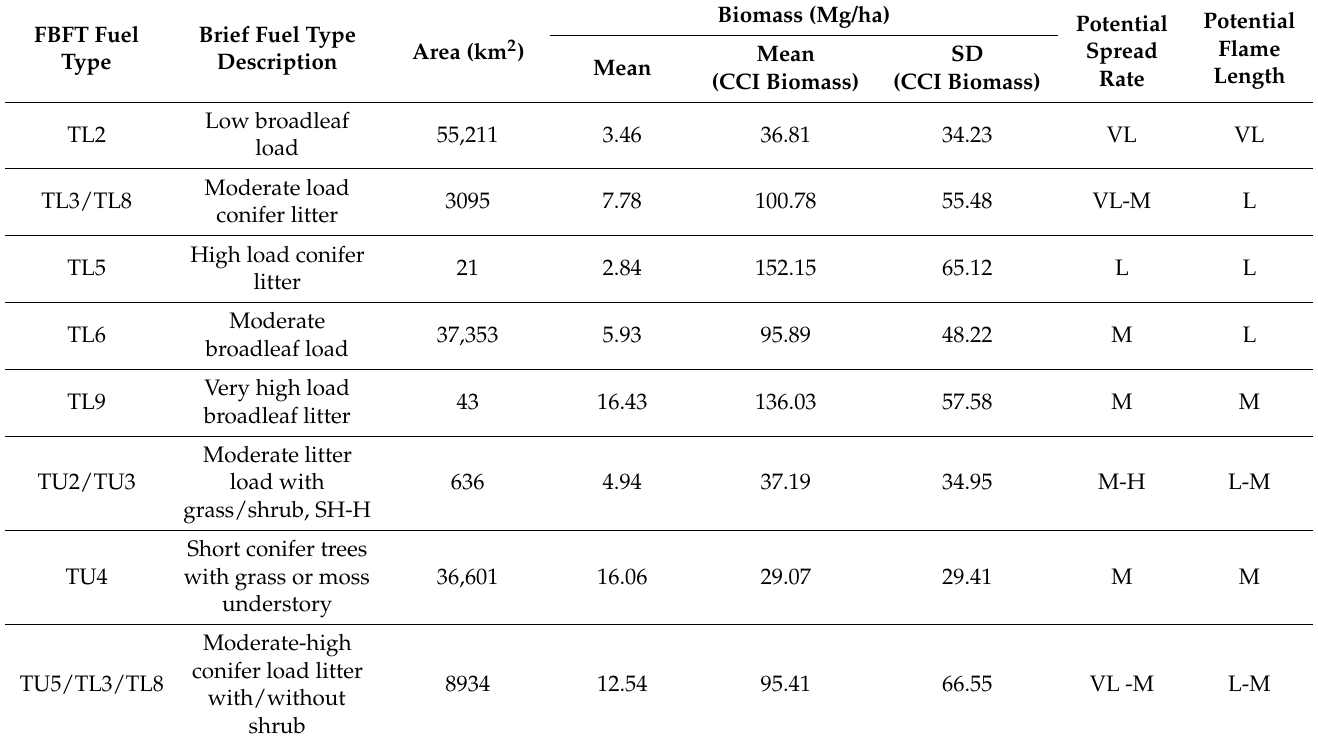
Table 4. Characterization and parameterization of the FBFT-adapted tree fuel types (SD: standard deviation). The values refer to mean fuel conditions and serve to predict fire behaviour inside and outside the fire